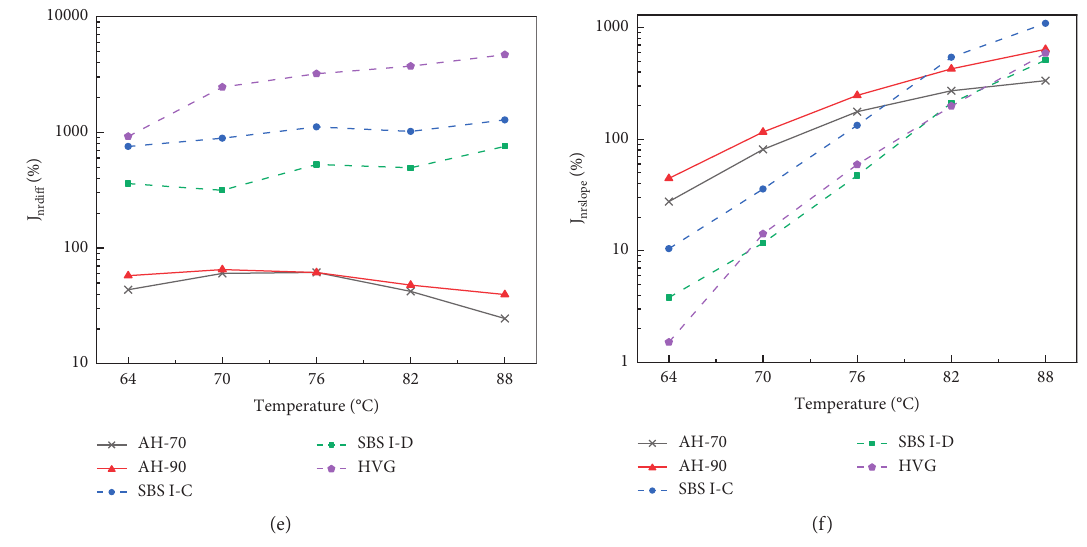
Figure 4: MSCR results at five different temperatures: (a) J